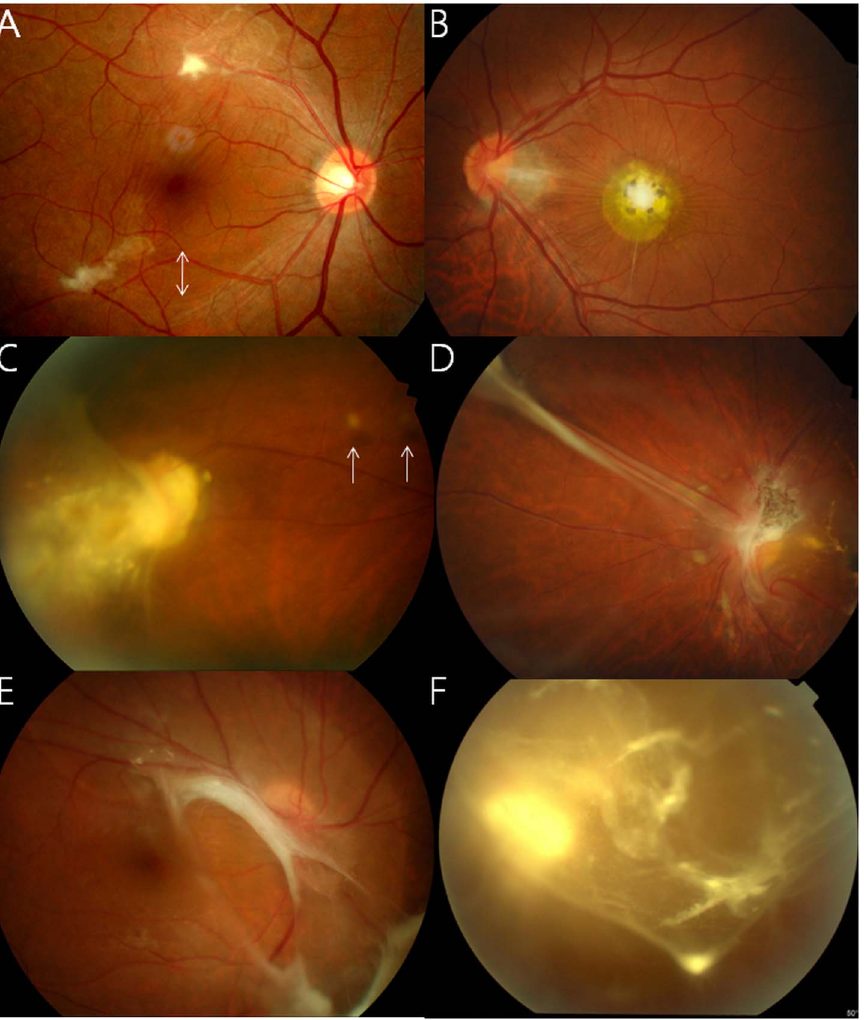
Figure 1. Funduscopic findings of ocular toxocariasis: Small amorphous posterior pole granulomas (A, B) with retinal nerve fiber layer defects (arrows), peripheral granulomas with round vitreous debris (C, arrow) and a tractional retinal fold (D), and vitreous findings, including tractional retinal detachment (E), whitish dot-like vitreous opacities, and vitreous veil (F).